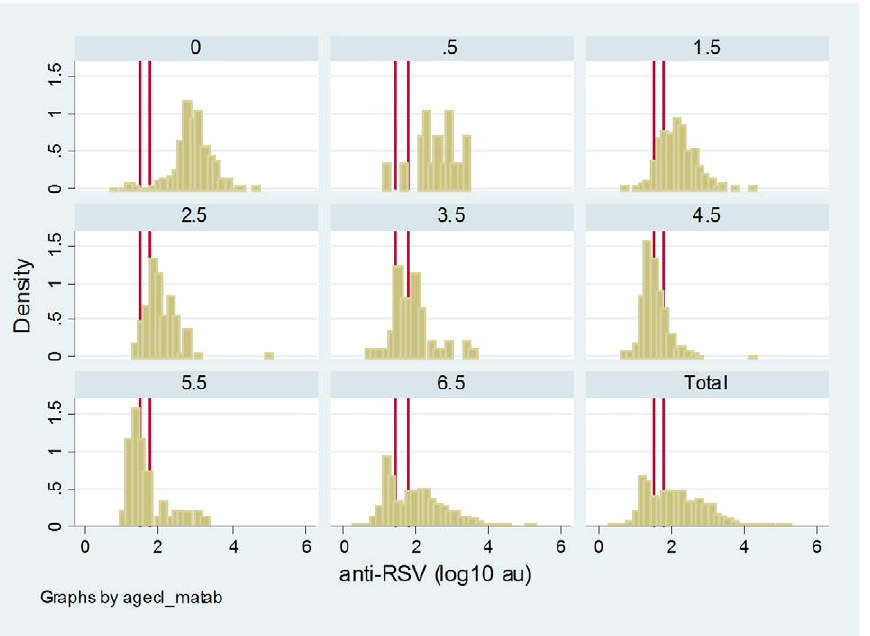
Figure 3. Frequency distribution of antibody titres (log 10 AU) by age class (months). Cut-off between seropositive and seronegative is shown by red lines and lies between 1.5–1.8 (log 10 AU).